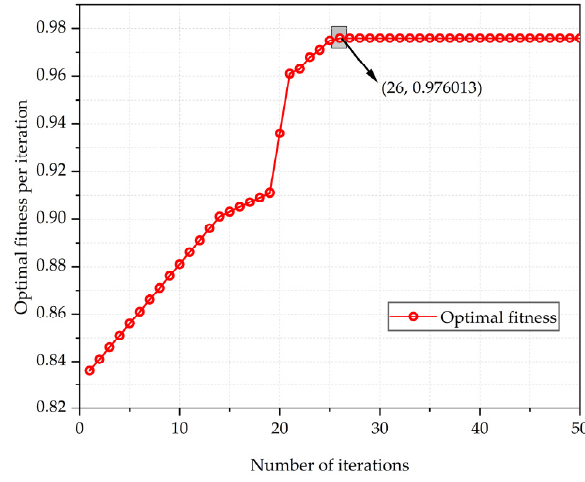
Figure 10. Diagram of evolutionary iterations.